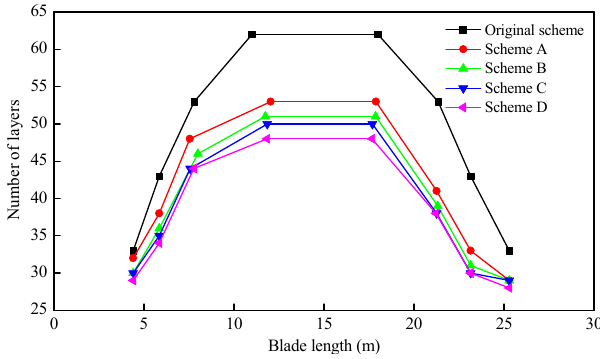
Figure 19. Comparison of material layup of the spar cap.